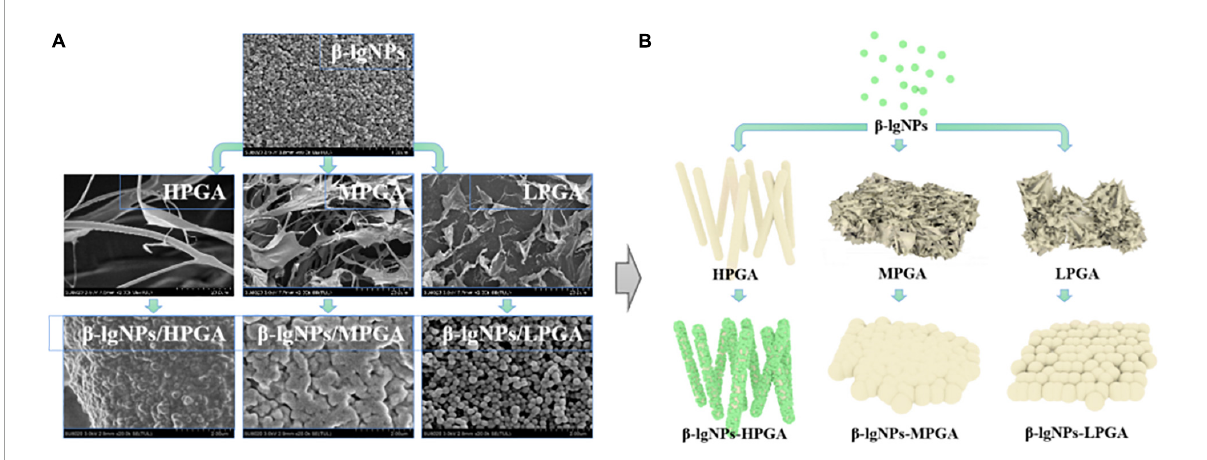
FIGURE6 SEM images (A) and schematic representation of the formation mechanism (B) of β -lgNPs, PGA and PGA- β -lgNPs complexes with different PGA M